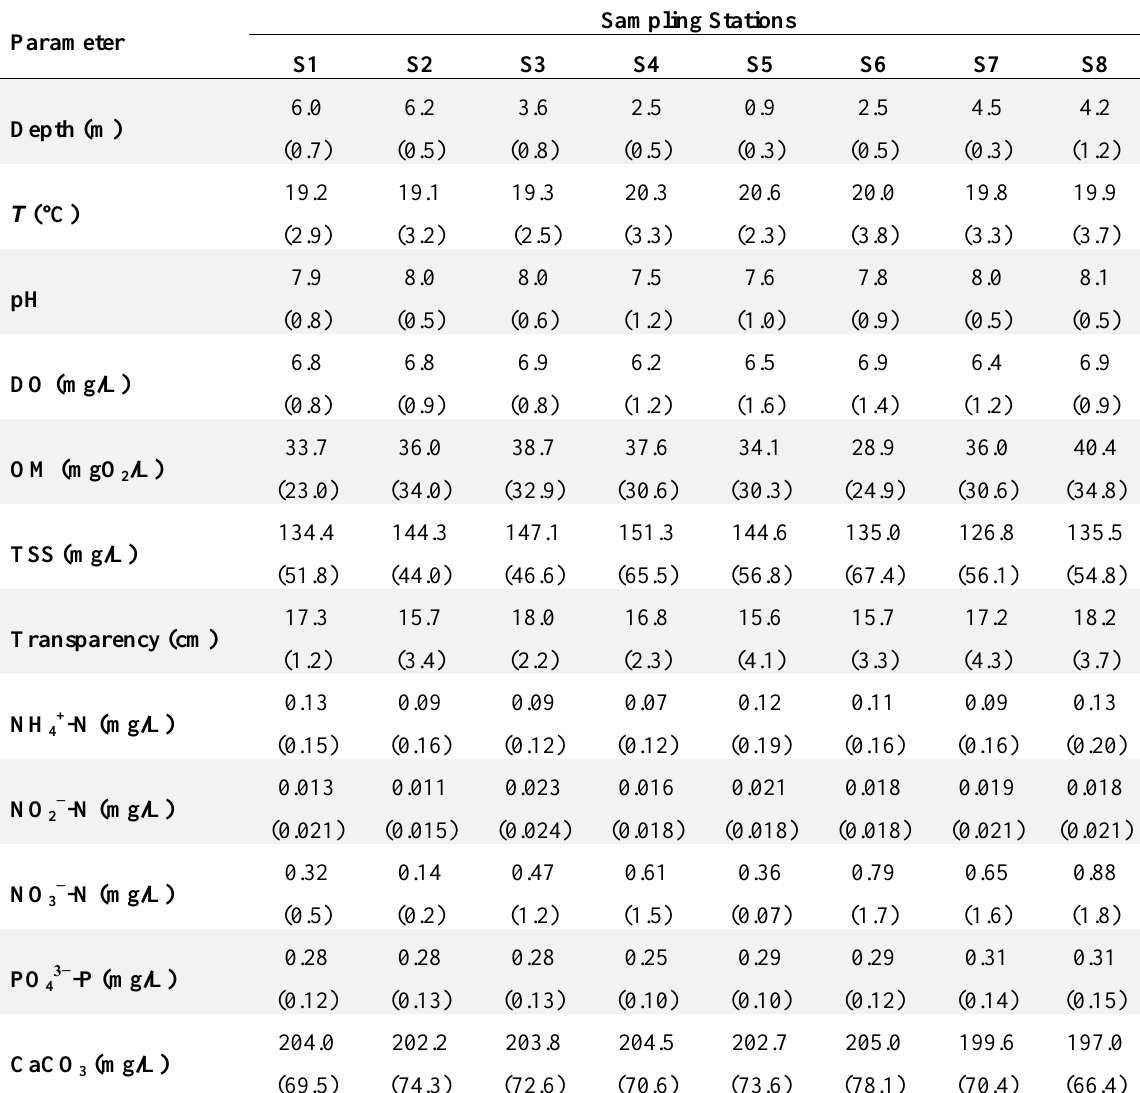
Table 2. Means of the physical and chemical parameters at the dam sampling stations are presented. Standard deviation (SD) (values within parentheses) illustrates the dispersion found at each station during the 6 sampling